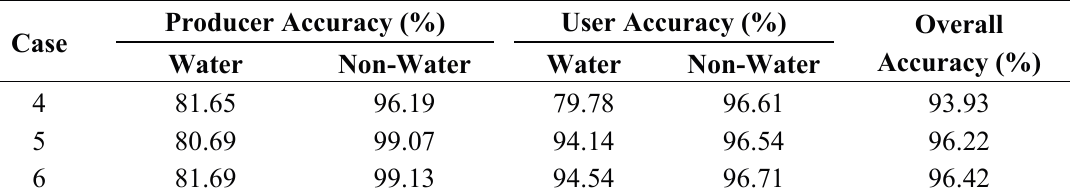
Figure 7. ( a ) Example of labelled objects (Gray: water, White: non-water); ( b ) Determination of threshold to remove the misclassified objects. Table 4. The water classification results after noise removal.